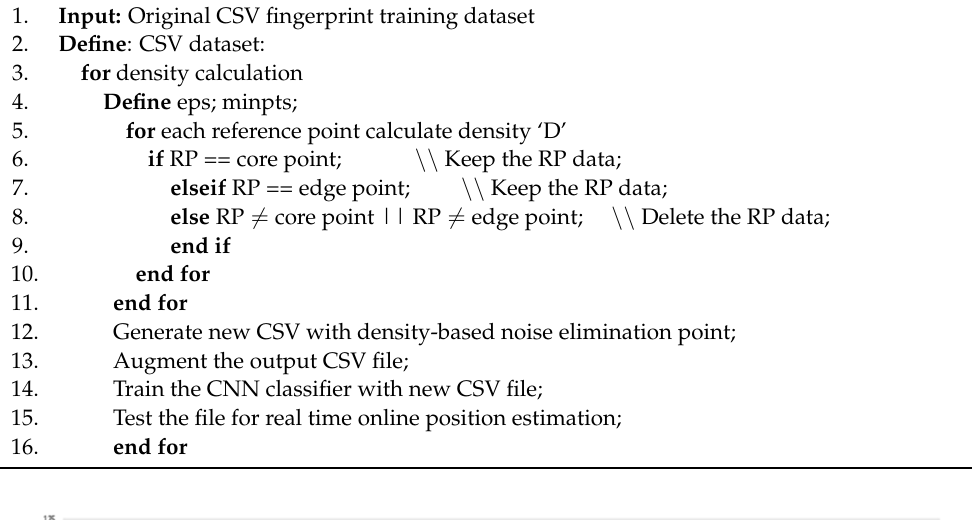
Algorithm 1: Pseudocode for Clustering-Based Noise Elimination and Position Estimation